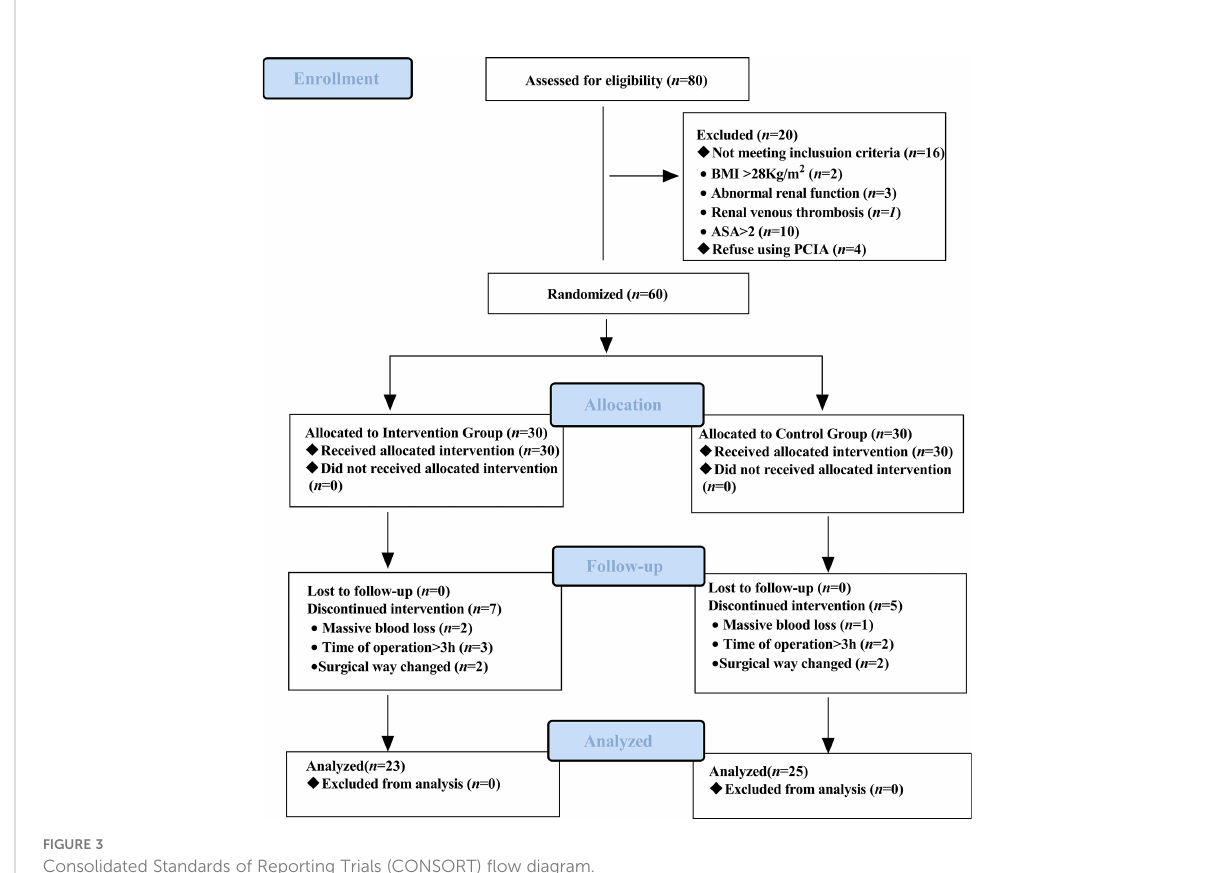
FIGURE 3 Consolidated Standards of Reporting Trials (CONSORT) fl ow diagram.